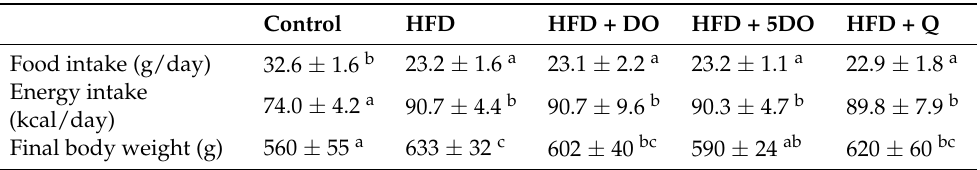
Table 1. Effects of dried onion powder and quercetin on food intake, energy intake and body weight in SD rats exposed to HFD 1 .